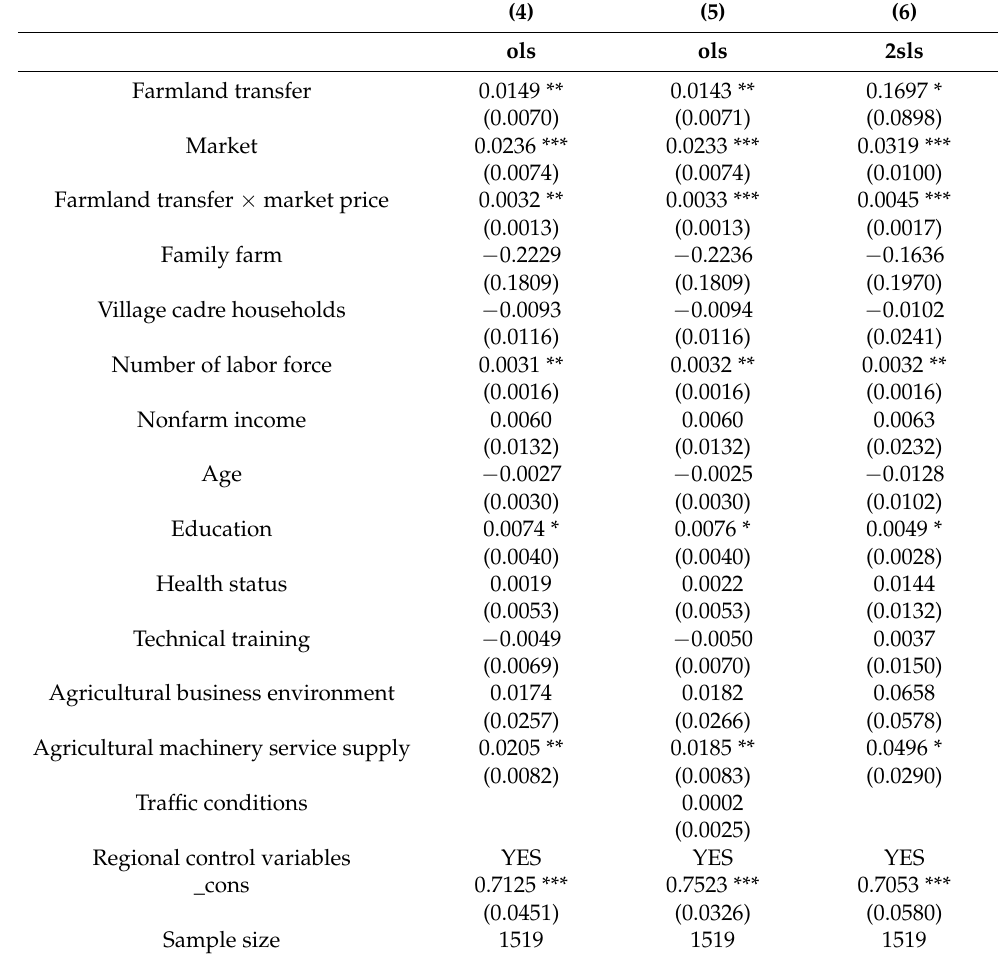
Table 4. Moderating effect of market price on farmland transfer on farmers’ technical